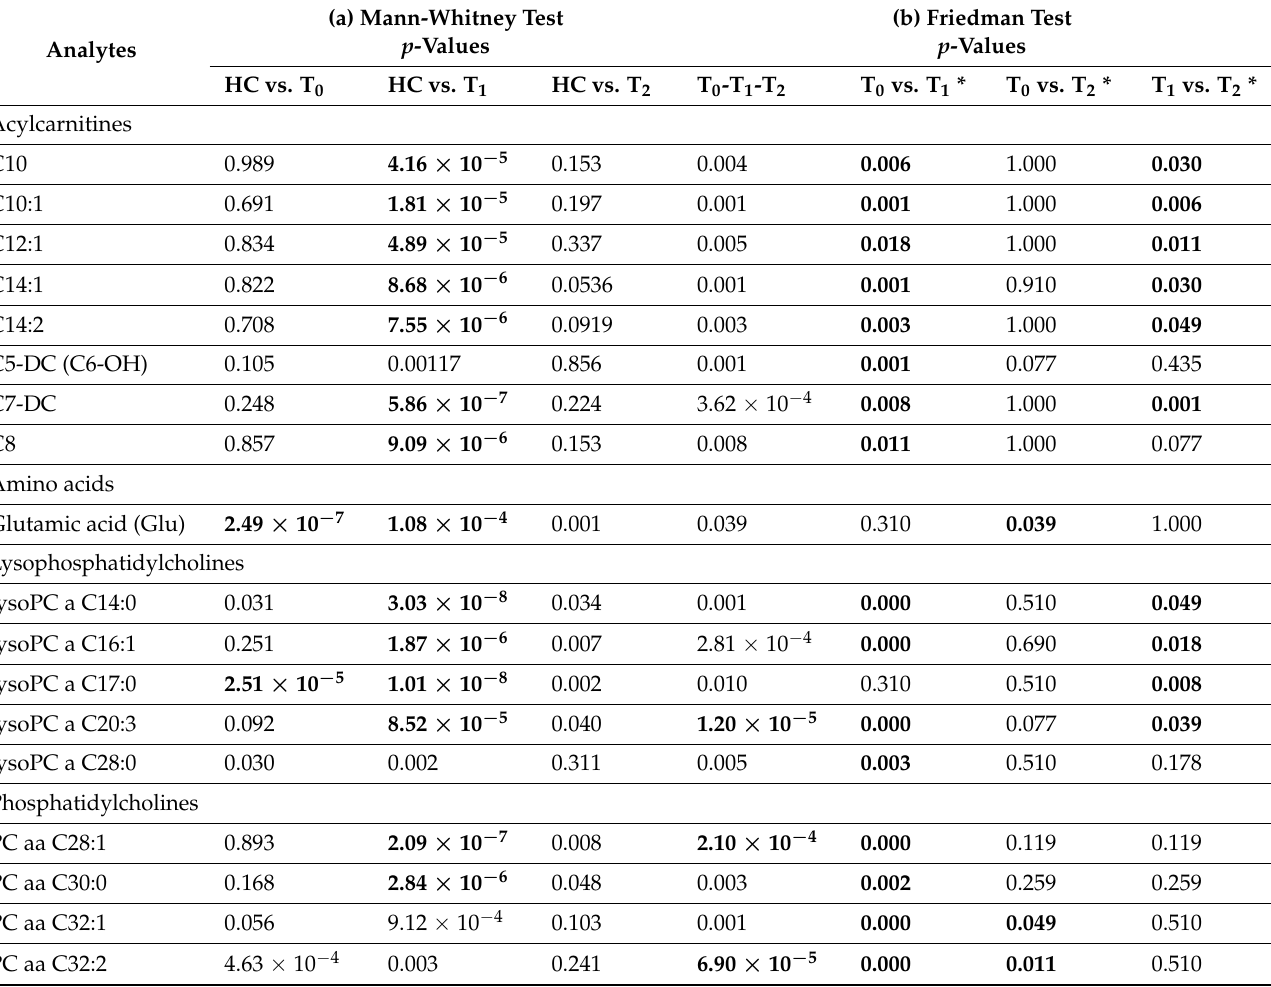
Table 2. Comparison of analyte concentrations (metabolites, sum of hexoses and ratios) between (a) healthy controls (HC) and cases at each measurement time point and (b) between cases at each measurement time point. Metabolite concentrations of HC and cases in three measurement time points were compared using Kruskal-Wallis test (Table S1). Post-hoc pairwise comparisons were conducted with Mann-Whitney test and Friedman